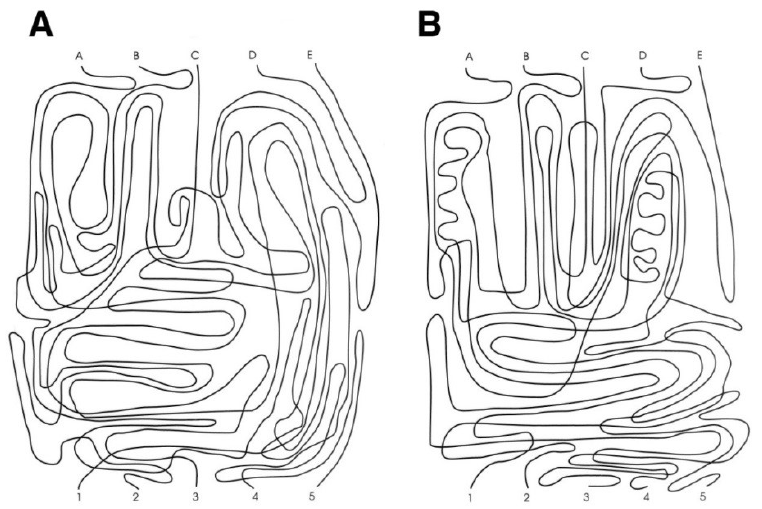
Figure 1. Groffman visual tracing test. The demonstration card was not shown. Panels ( A ) and ( B ) show respectively the card A and B .